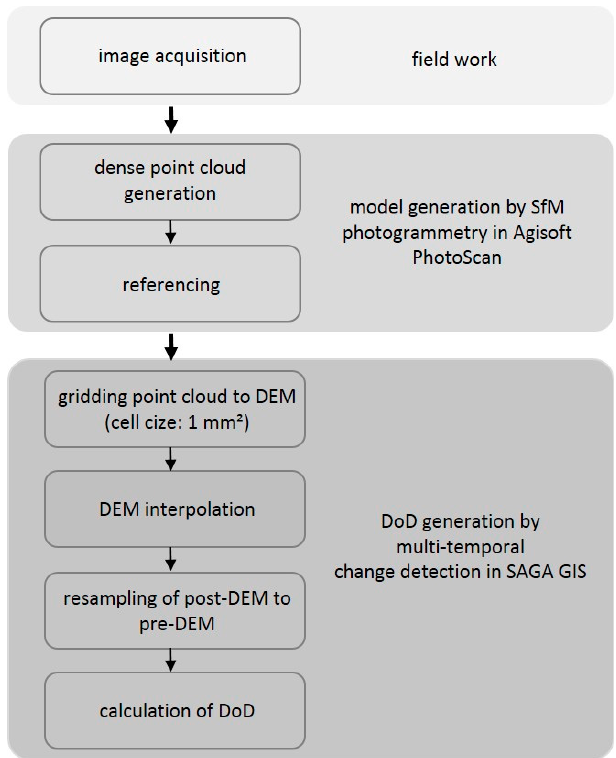
Figure 5. Workflow and applied software of the present study.